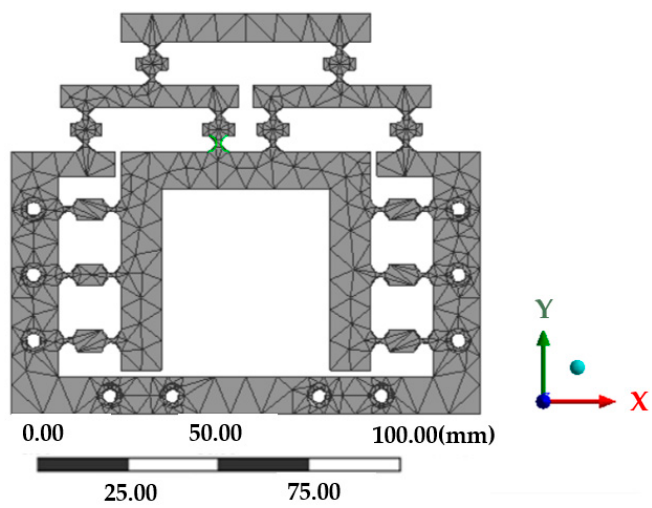
Figure 8. Meshing of the micro-drive reduction mechanism.